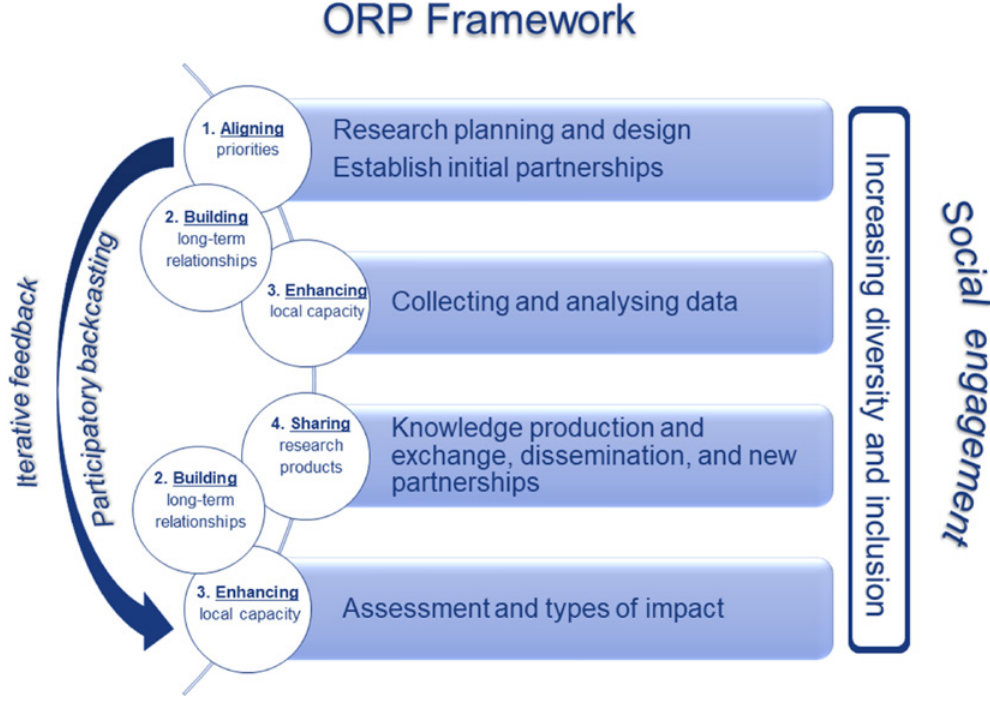
figure 2: framework for the olive Ridley Project (oRP), including all the action areas tackled by the organization (credit: